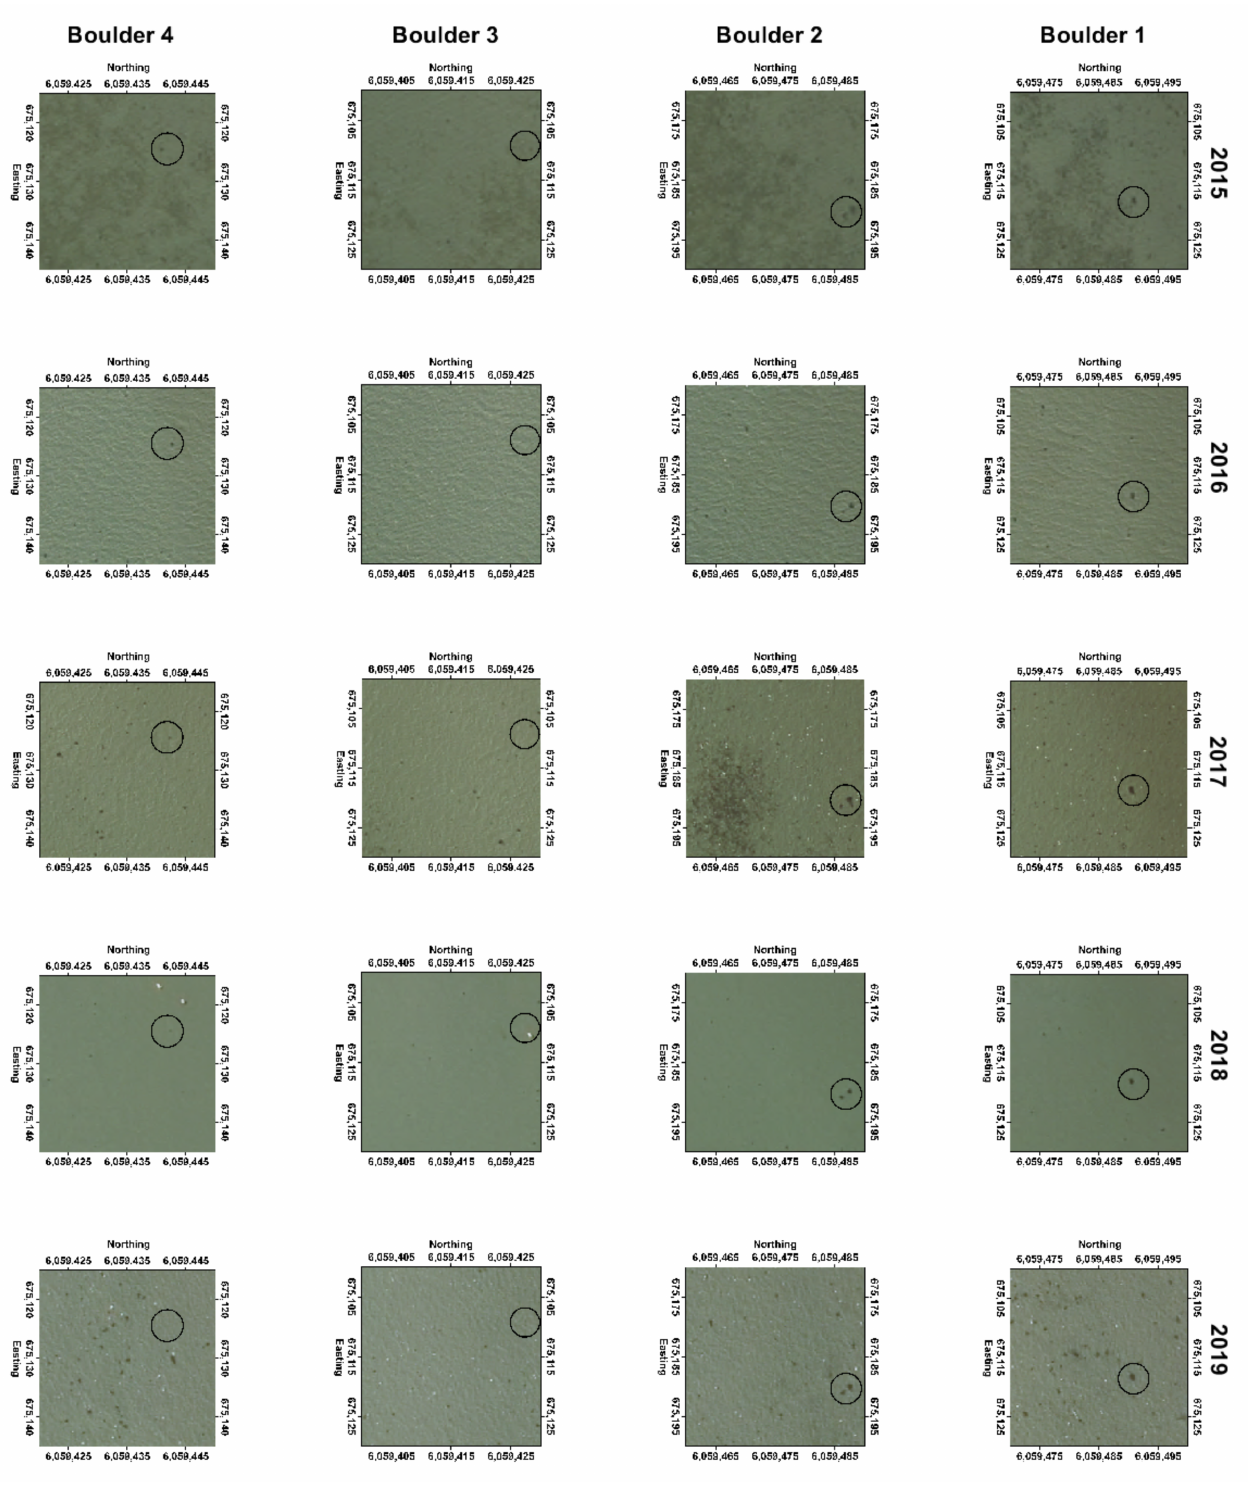
Figure 4. Groundtruth for the four areas representing one boulder each (in black circles), shown on orthophotos from 2015, 2016, 2017 and